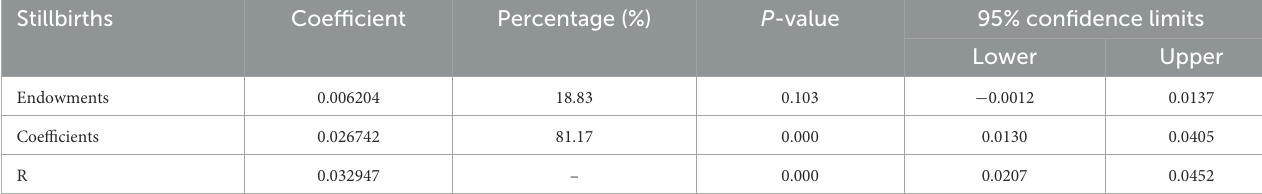
TABLE 3 Overall multivariate decomposition analysis result of the decrease in stillbirths, PDHS from 2012 to 2013 and from 2017 and